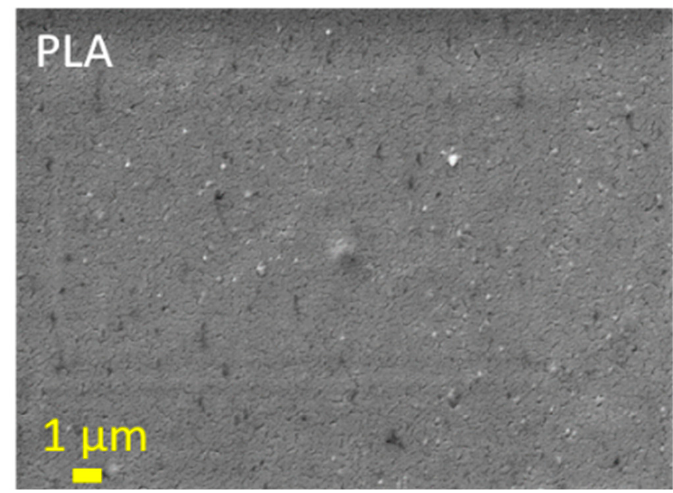
Figure 7. SEM image of uncoated PLA film that was used as reference.